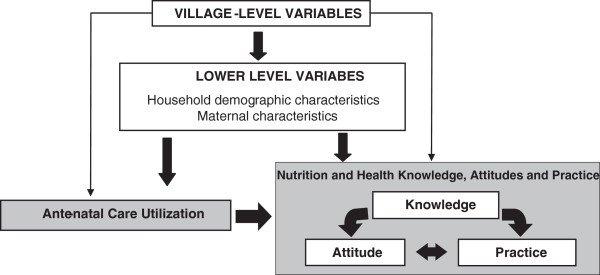
Conceptual model.